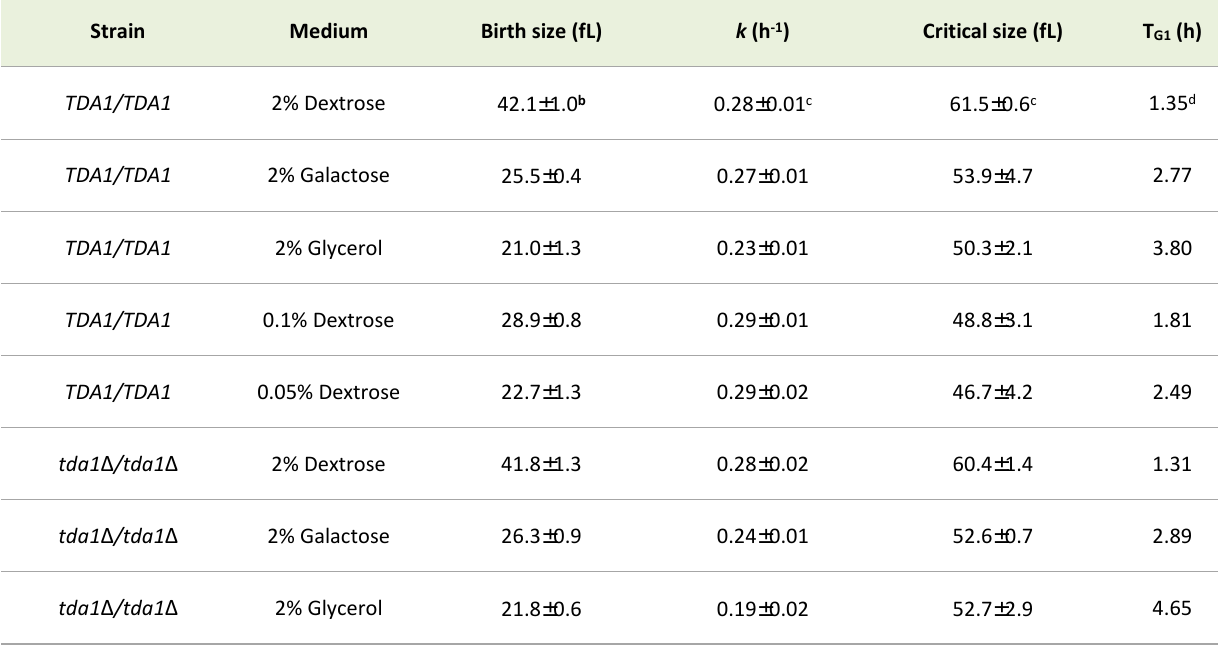
TABLE 1. G1 parameters in different nutrients of wild type and tda1 ∆ /tda1 ∆ cells a .